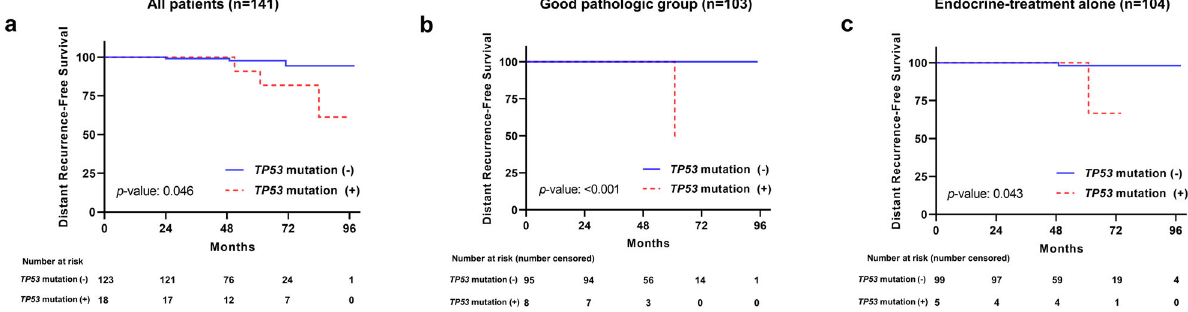
Fig. 4 Kaplan – Meier survival plots for distant recurrence-free survival (DRFS) based on TP53 mutation. Rates of DRFS according to TP53 mutations in a all patients, in b subset with good pathological (PR + /low HG/low Ki-67) outcomes, and in c patients given endocrine treatment alone ( p = 0.046, p < 0.001 and p = 0.043, respectively; log-rank tests).